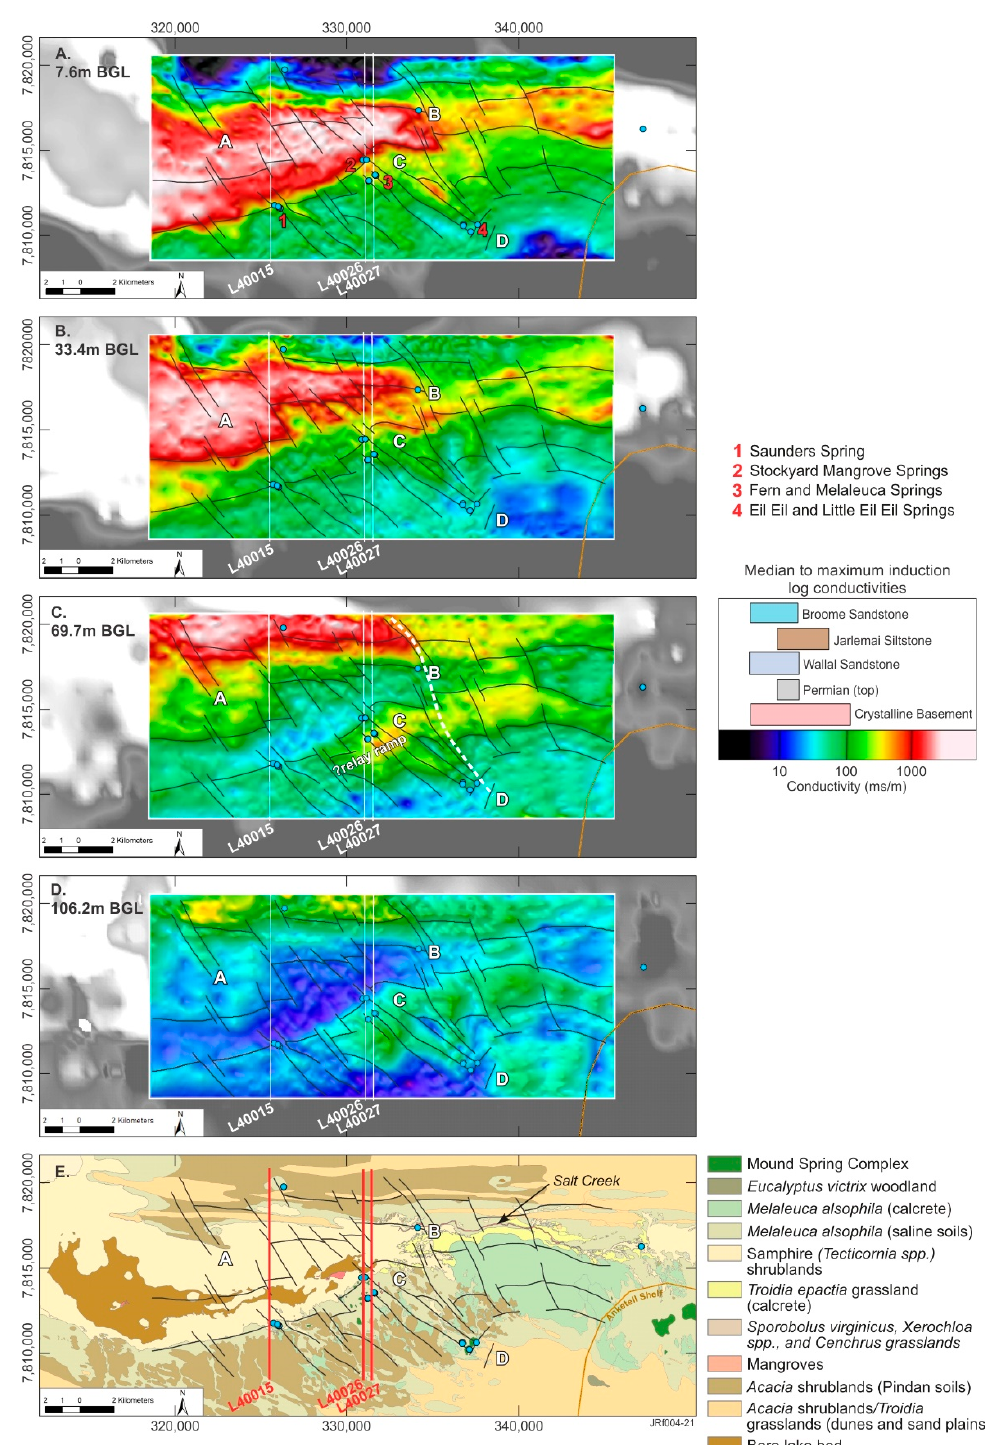
Figure 6. TEMPEST AEM 2D inversion (2020) overlain on greyscale images of CDIs presented in Figure 3; pseudo-colored interval conductivity images (CDIs) for depths of ( A ) 7.6 m BGL; ( B ) 33.4 m BGL; ( C ) 69.7 m BGL and ( D ) 106.2 m BGL and a ( E ) vegetation map [47]. Spring sampling locations are blue dots; AEM flight lines L40015, L40026 and L40027 are white lines, geological faults are black lines; within maps, numbers A to D represent major interpretation domains discussed in the text. Note: connecting fault is shown as a white dashed line in C and conductivity key induction log conductivities are from [60] the Callawa Fm. (Cretaceous) is not shown but is coeval with the Broome Sandstone and displays a similar data range.